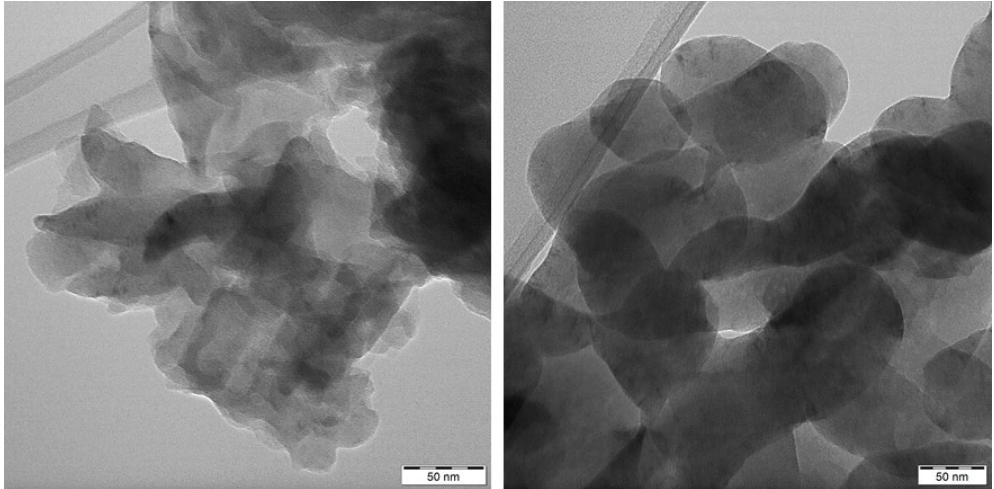
Figure 10. TEM images of bulk ( left ) and bulk 30 % H 2 O 2 nanomaterials ( right ).